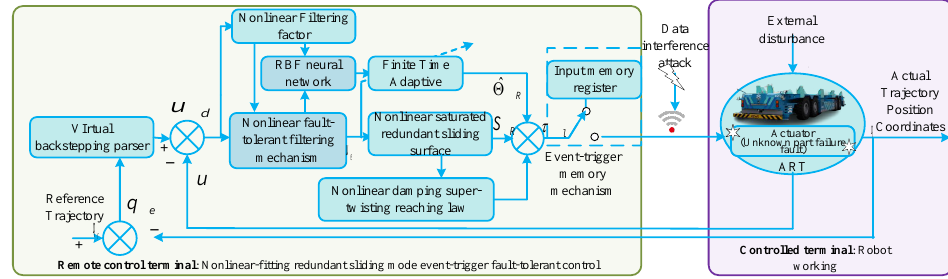
Figure 3. Schematic diagram of artificial intelligence transportation robots with a trajectory-tracking control